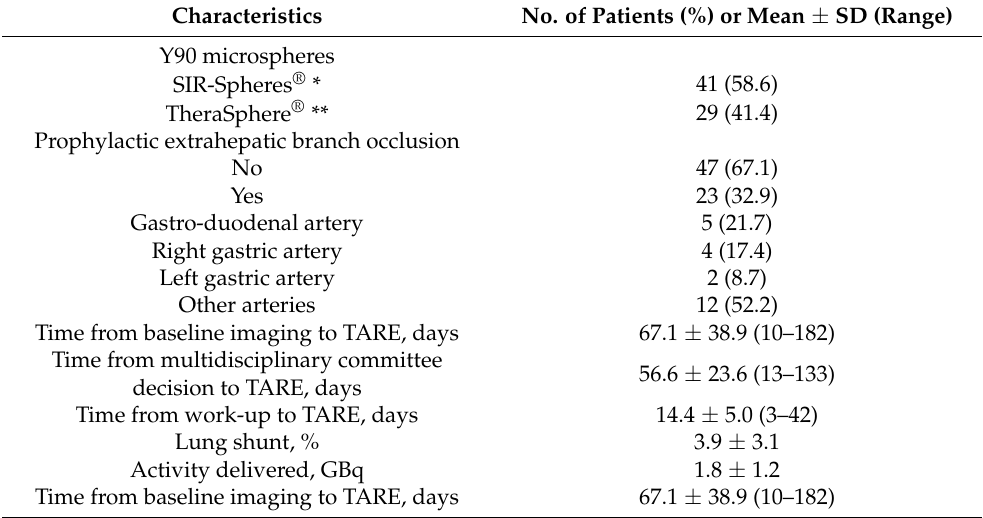
Table 3. Characteristics of transarterial radioembolization (TARE).